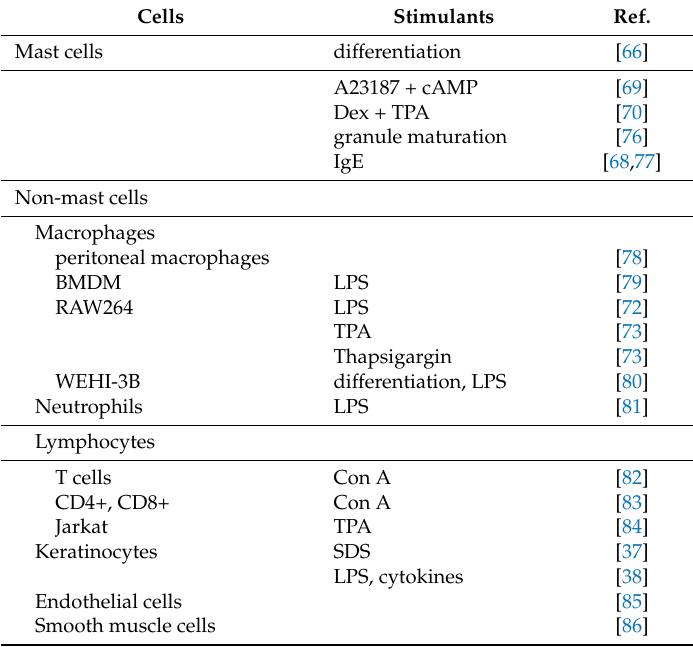
Table 1. Histidine decarboxylase induction in